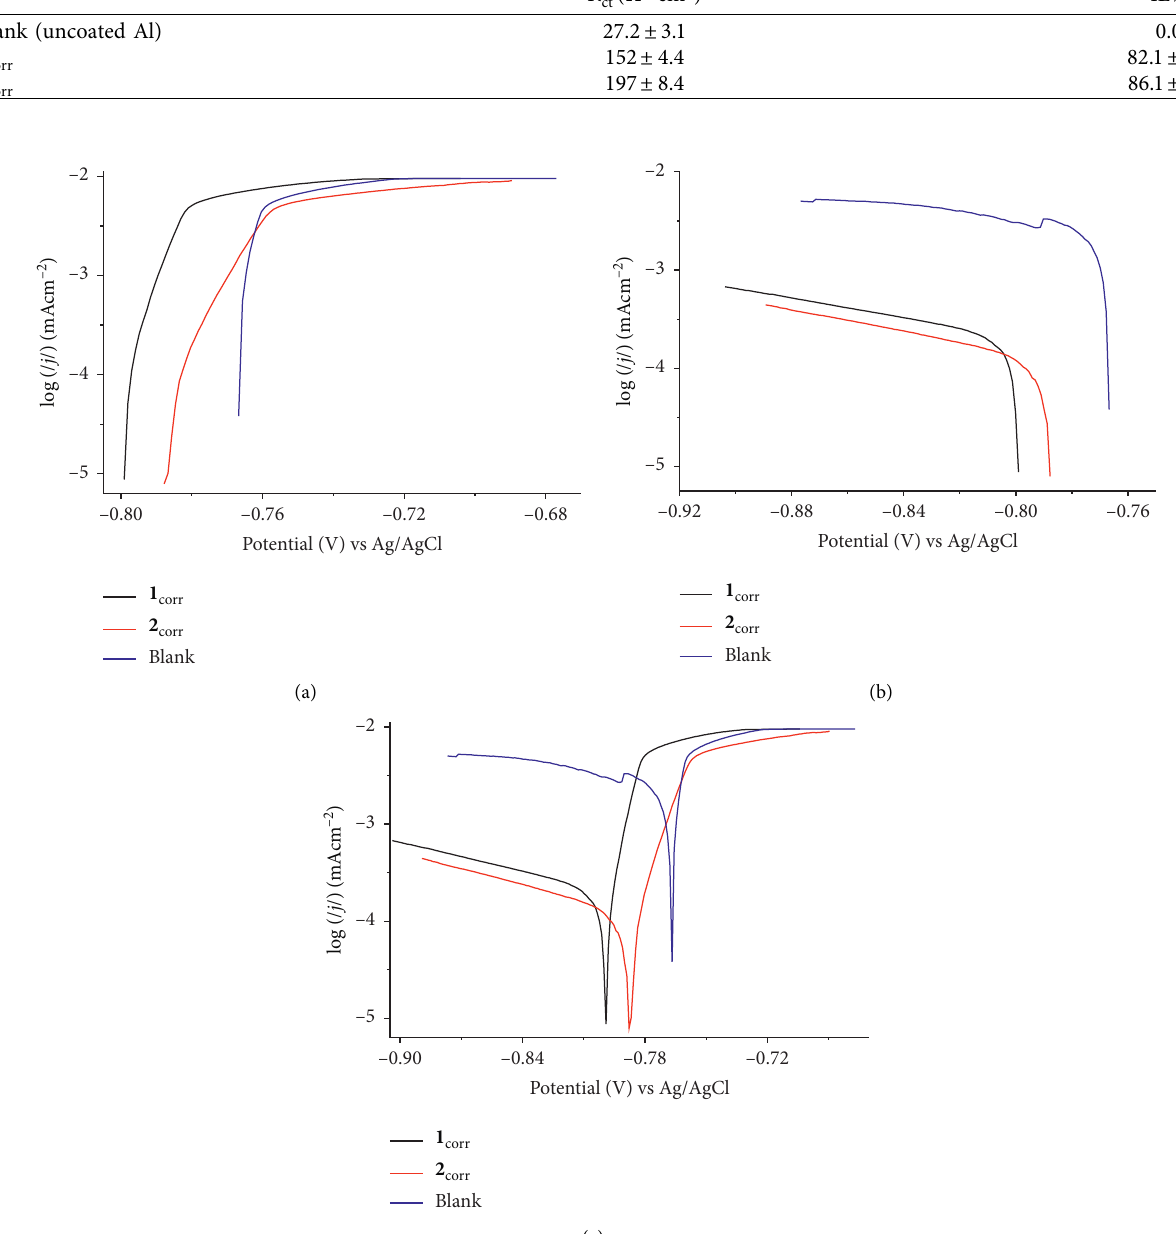
and 2 , respectively, are for coated aluminium with corr corr